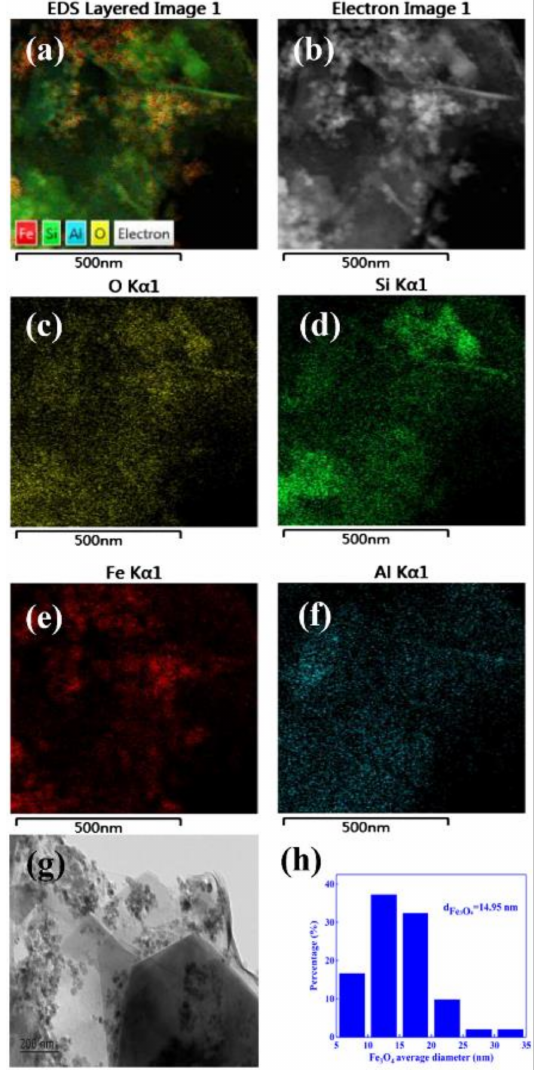
Figure 9. EDX mapping and High-Resolution Transmission Electron Microscopy (HRTEM) image of the Fe 3 O 4 /heulandite catalyst. ( a ) EDS layered image; ( b , g ) electron images; ( c ) oxygen, ( d ) silicium; ( e ) iron; ( f ) aluminum; ( h ) average diameter of magnetite